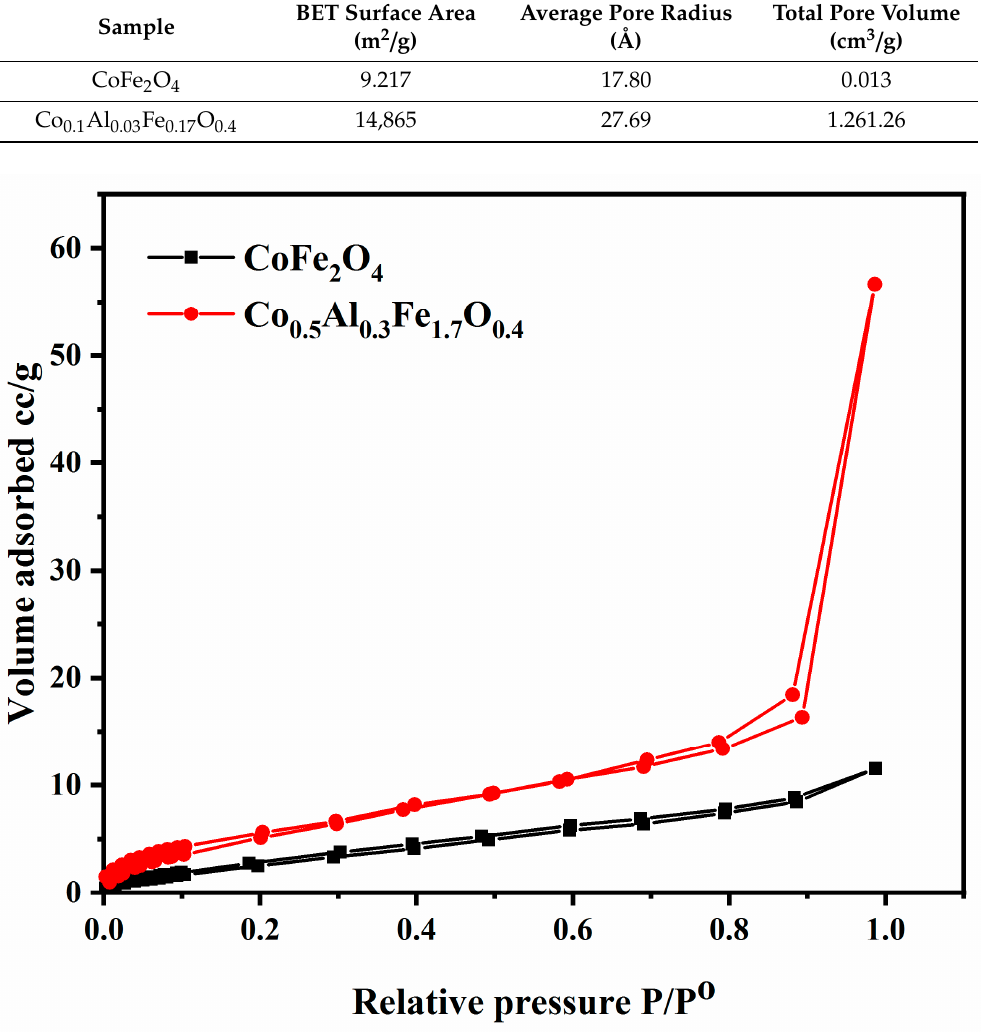
Figure 9. Nitrogen adsorption / desorption studies of CoFe 2 O 4 and Co 0.1 Al 0.03 Fe 0.17 O 0.4 .